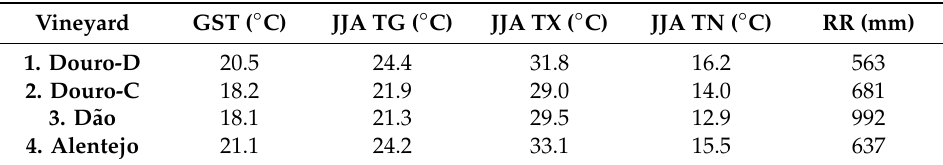
Table 2. Climatic characterization of the studied sites over the baseline period of 1991–2017. RR: annual mean precipitation (in mm); GST: growing season (April–October) mean temperature (in ◦ C); JJA TG / TX / TN: summertime mean (June–August) of the daily mean (TG), maximum (TX) and minimum (TN) temperature (in ◦ C).